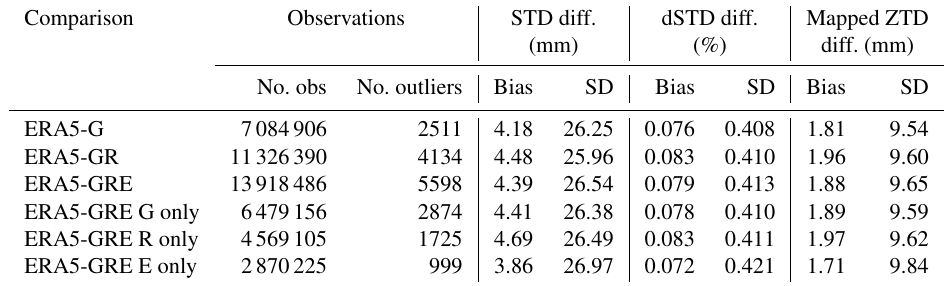
Table 7. The STD biases and standard deviations between ERA5 and three GNSS solutions (whole world: 663 stations). The statistics are calculated four times per day (at 00:00, 06:00, 12:00, and 18:00UTC) and averaged over the year 2020. Comparison Observations STD diff.